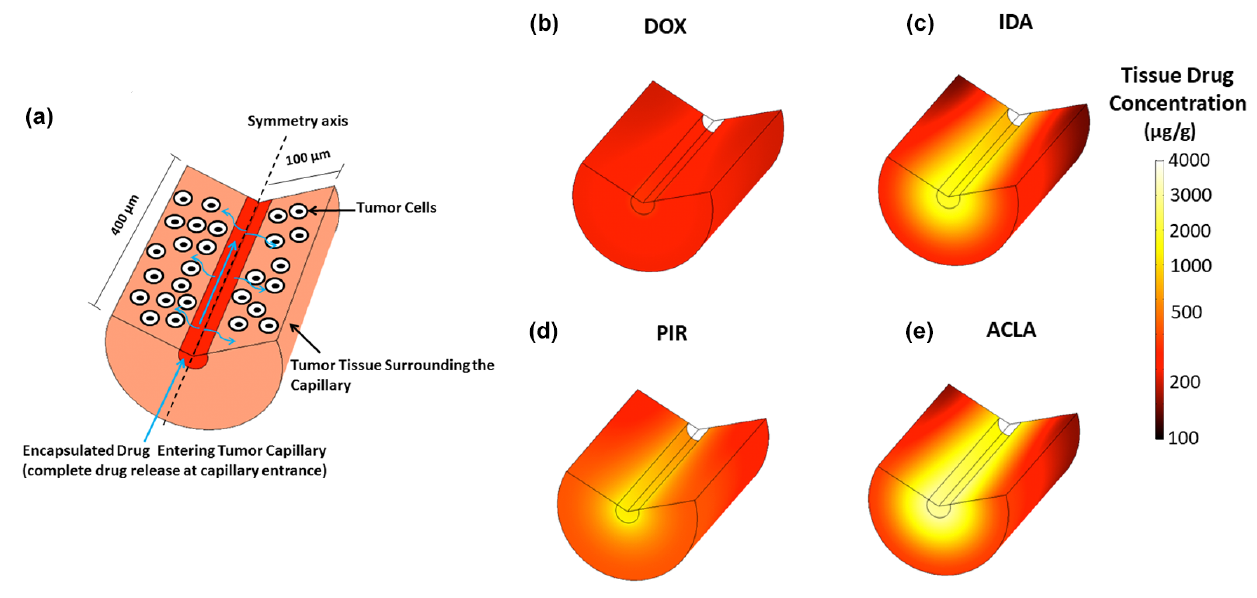
Figure 12. TSL delivery depends on drug. ( a ) Computer model simulated TSL-based drug delivery to SVR cancer cells surrounding a tumor capillary. Drug concentration after 60 min hyperthermia is shown for ( b ) doxorubicin (DOX), ( c ) idarubicin (IDA), ( d ) pirarubicin (PIR), and ( e ) aclarubicin (ACLA). Tumor drug uptake in ( b – e ) is largely dictated by cell uptake kinetics of the drug (see Figure 11). Drugs with fast cell uptake (ACLA, IDA) also result in highest tissue uptake. Figure reproduced from [172] (published under CC BY license).